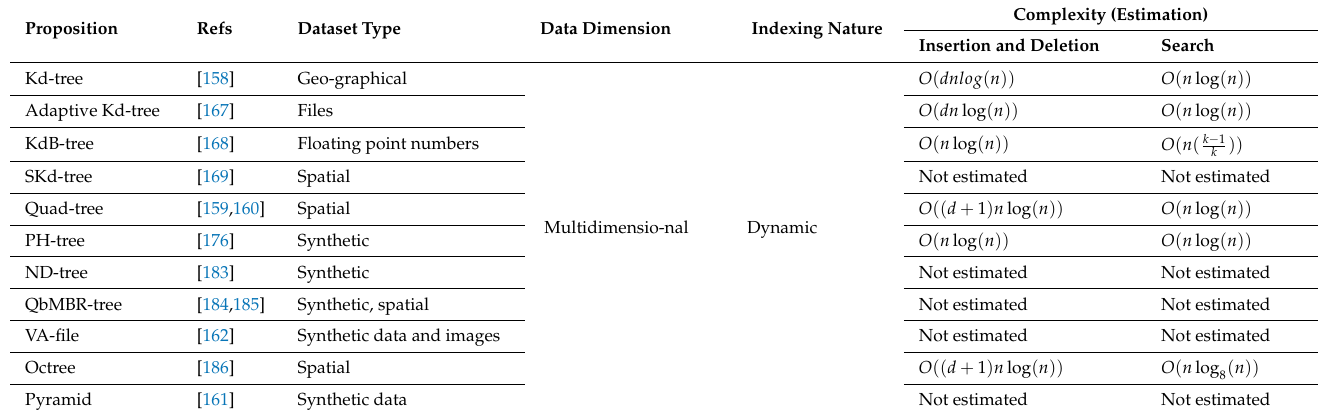
Table 9. Analysis of multidimensional indexing techniques based on space partitioning.